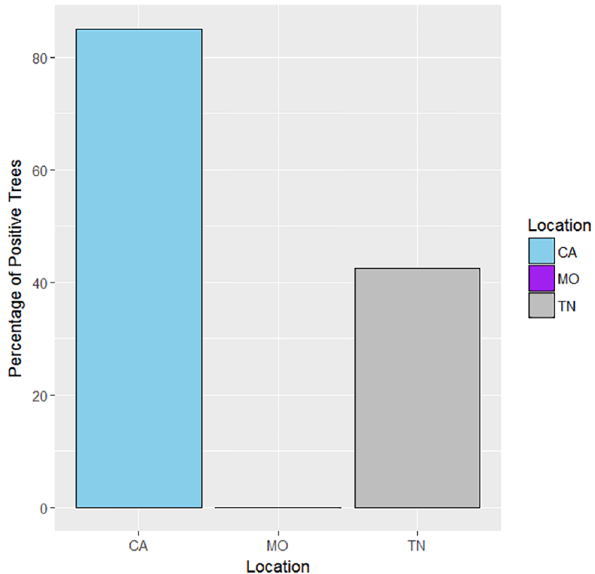
Fig 3. Molecular detection of thousand cankersdisease organisms ( Geosmithia morbida and/or Pityophthorus juglandis ) among positive trees for all samples and both drilling methods.